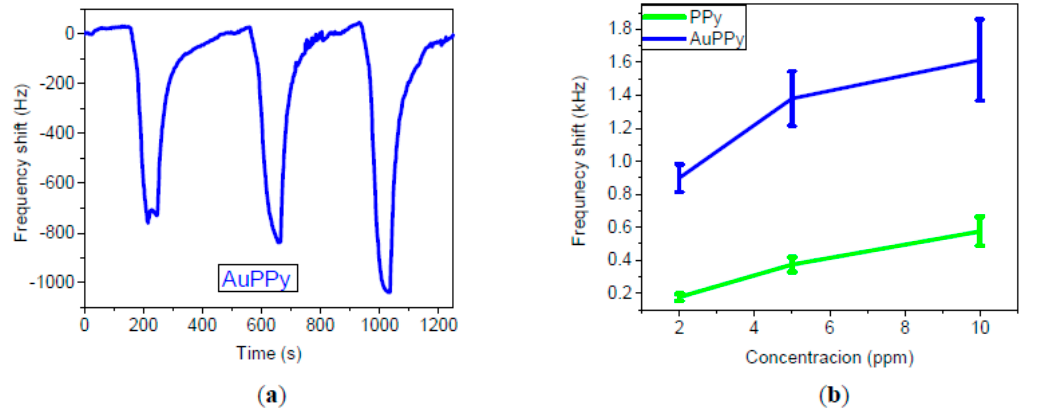
Figure 3. ( a ) Response of the AuPPy (1:10) based-LW sensor to 2 ppm of NH 3 ; ( b ) Calibration curves to NH 3 using the PPy and AuPPy (1:10)